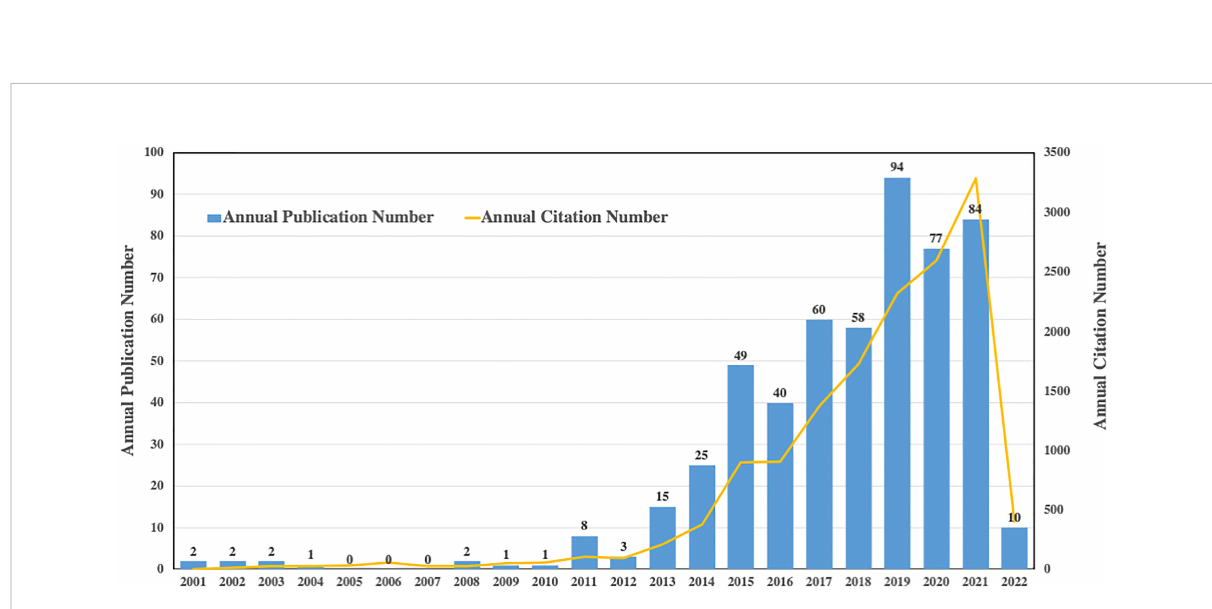
FIGURE 2 Annual publication growth trend of IL-37 research.